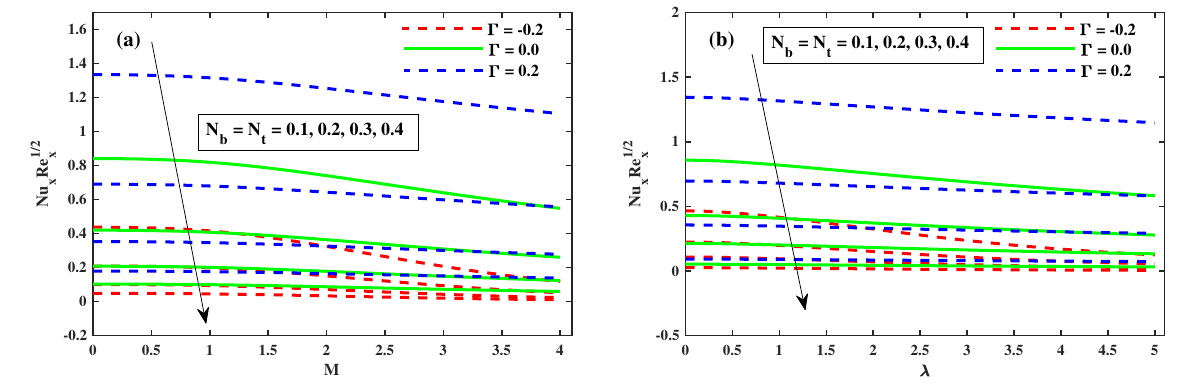
Figure 11. The variation of Nusselt number with N b , N t against M in ( a ) and against λ in ( b ).